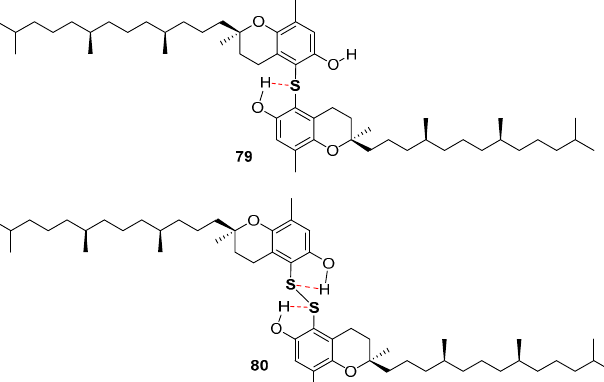
Figure 17. Chalcogens containing ditocopherols prepared so far.